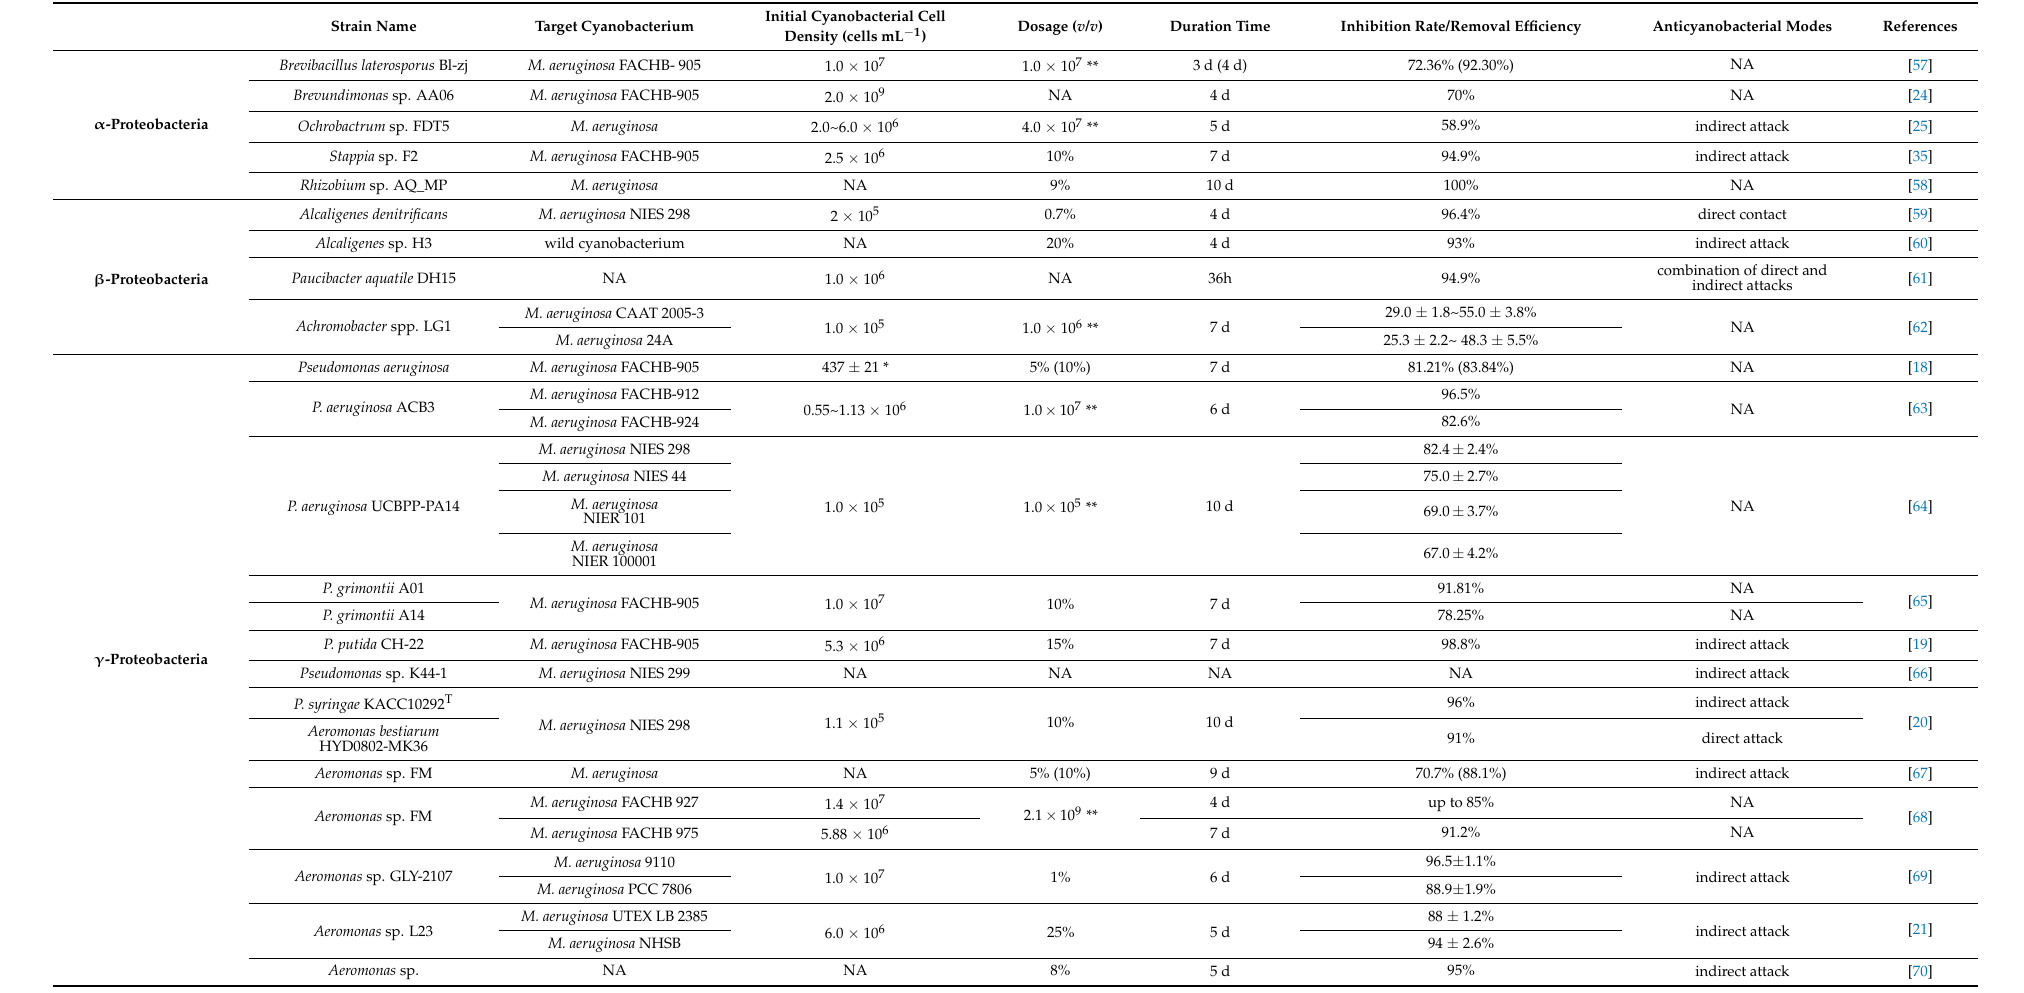
Table 1. Summary of anticyanobacterial microorganisms and their anticyanobacterial